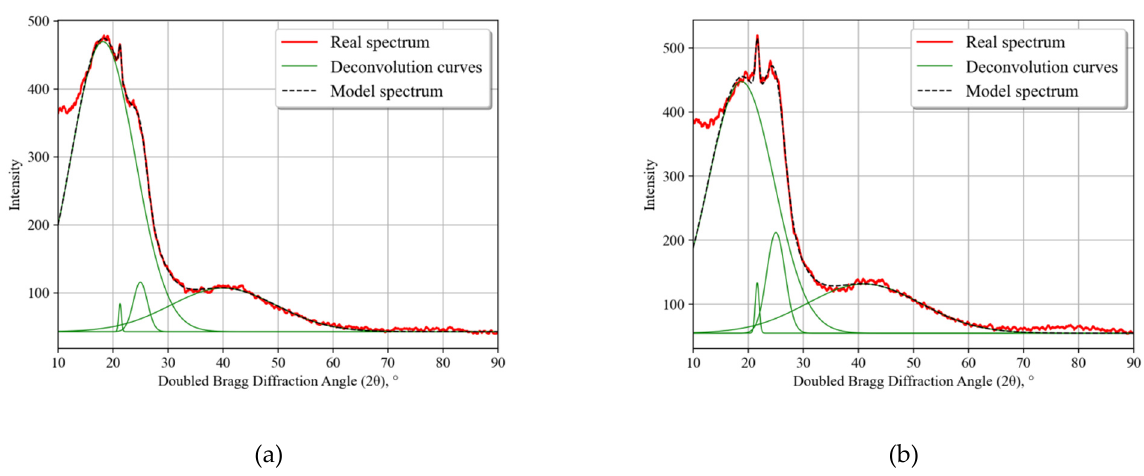
Table 2. The microelement composition of asphaltenes from VacRes and VisRes (% wt).